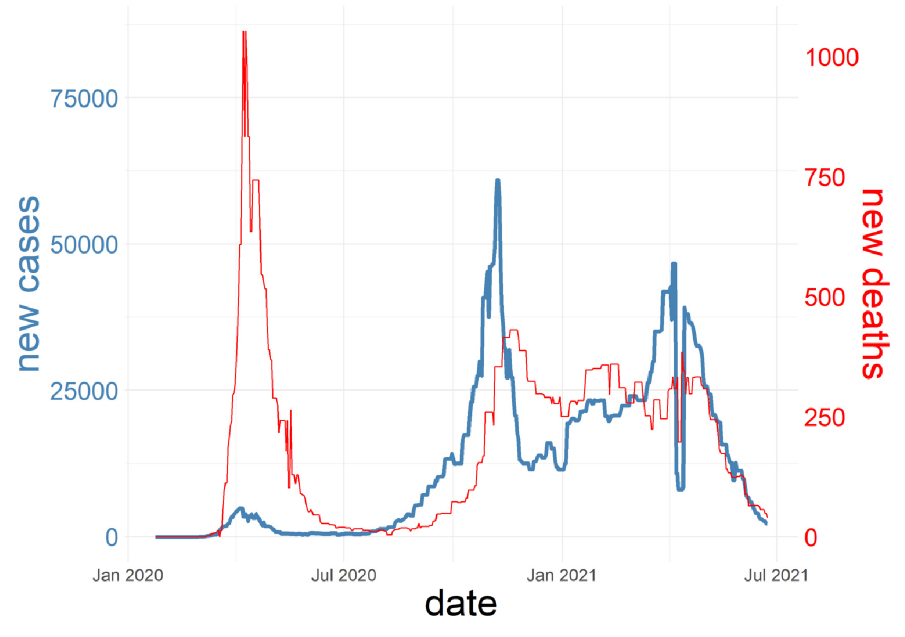
Fig 12. Evolution of new deaths and new